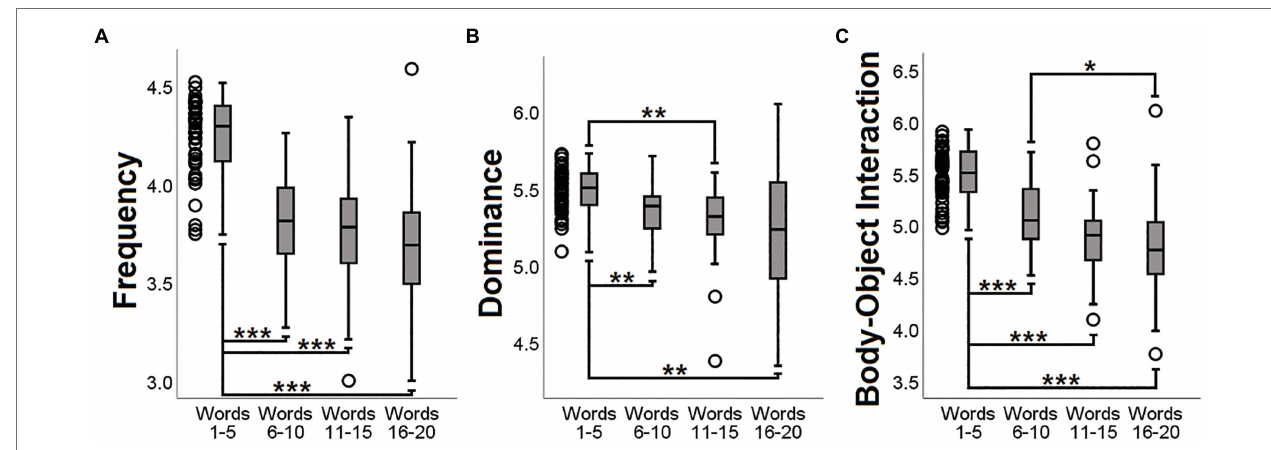
FIGURE 5 | Post hoc analyses of downward trends showing significant results. For all three semantic indices ( A : Frequency; B : Dominance; C : Body-Object Interaction), the first group of words (illustrated as dots on the left-hand side) was significantly different from the other groups. *** p < 0.001; ** p < 0.01; * p < 0.05. All p -values were